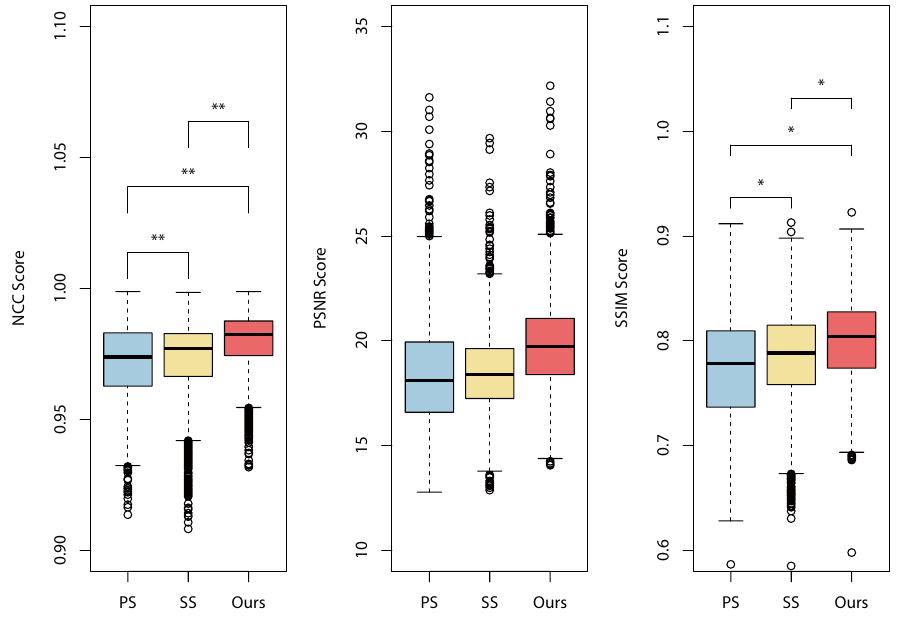
Figure 7. Statistical DR results of the NCC, PSNR, and SSIM evaluations. Remark: (significance: (**) p < 0.01 and (*) p <